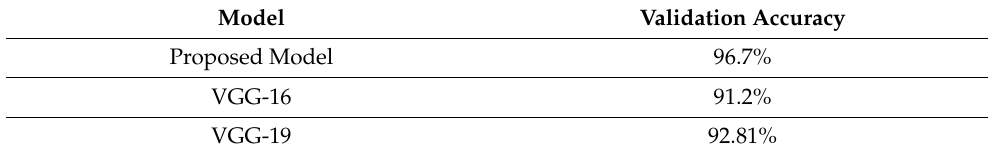
Table 2. Comparison of different